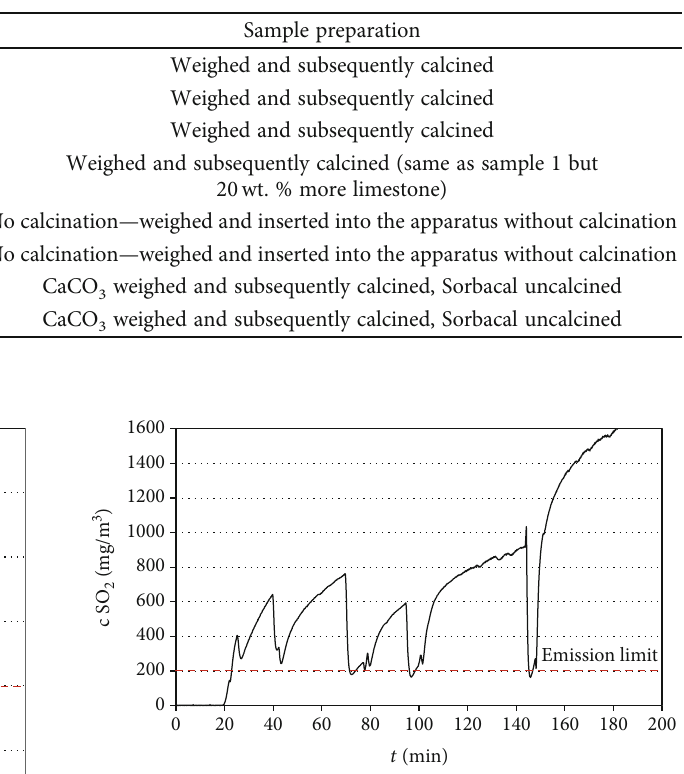
Table 3: Description of studied samples.